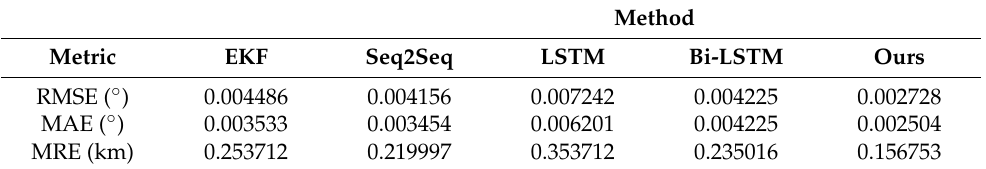
Table 4. Comparison of the proposed method with the other four baseline methods in terms of RMSE, MAE and MRE.